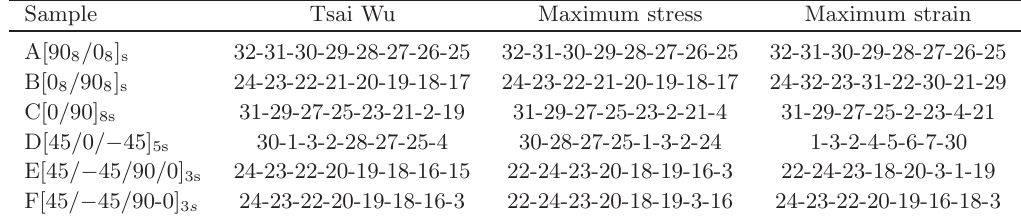
Table 8. Successive failures results obtained by numercical analysis.